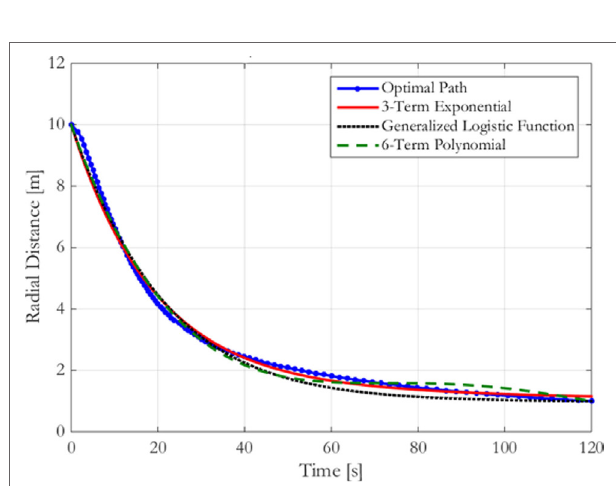
FigUre 5 | Fit error over number of terms for sums of exponentials, sums of polynomials, and the generalized logistic function